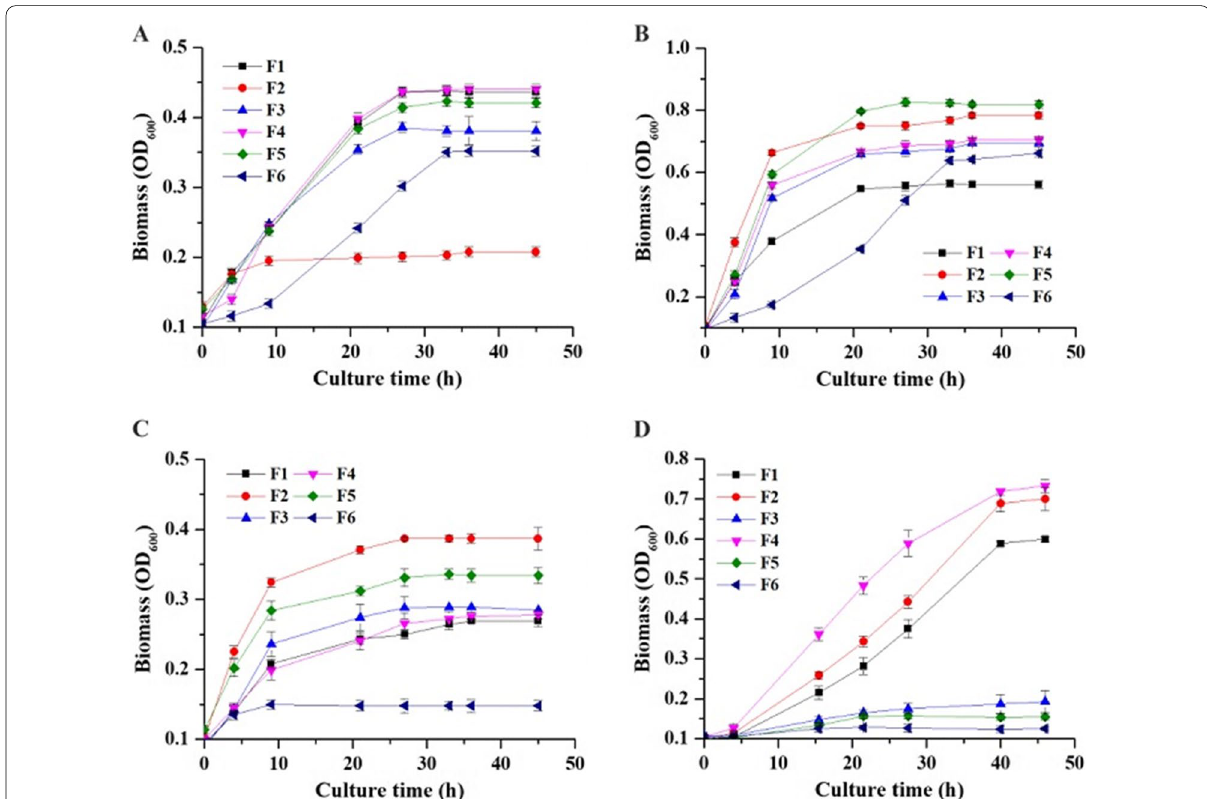
Fig. 2 Growth phenotypes of different strains with different nitrogen sources. A ammonium, ( B ) glutamine, ( C ) arginine, ( D ) glutamate. Strain denotes: wild type (F1), ∆ gdhA (F2), ∆ gdhB (F3), ∆ gltB (F4), ∆ gdhA ∆ gdhB (F5), ∆ gdhA ∆ gdhB ∆ gltB